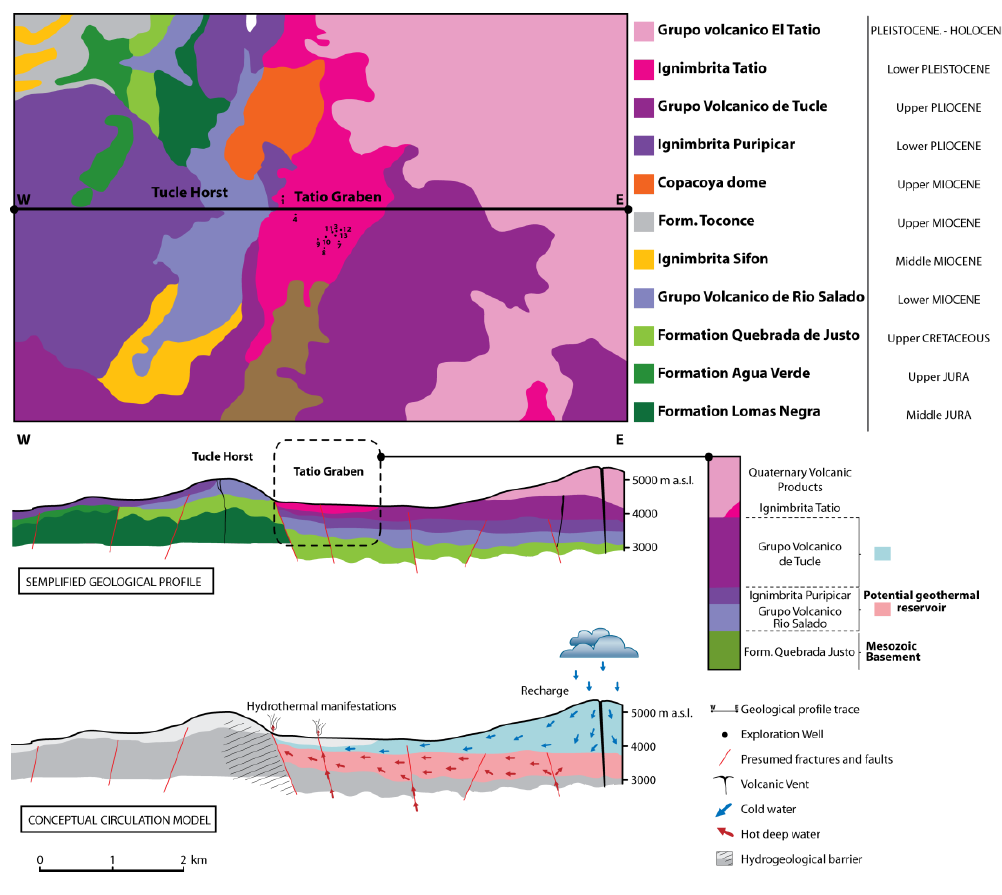
Figure 2. Simplified geological map of the El Tatio geothermal field, geological profile and circulation conceptual model. The dashed box represents the area in Figure 3 (modified from